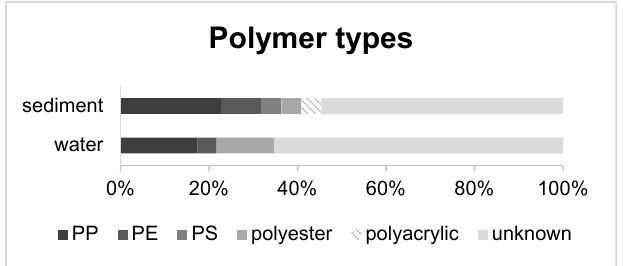
Figure 5. Polymer abundances of 45 representative particles (5.1%) in percentage from water and sediment samples.